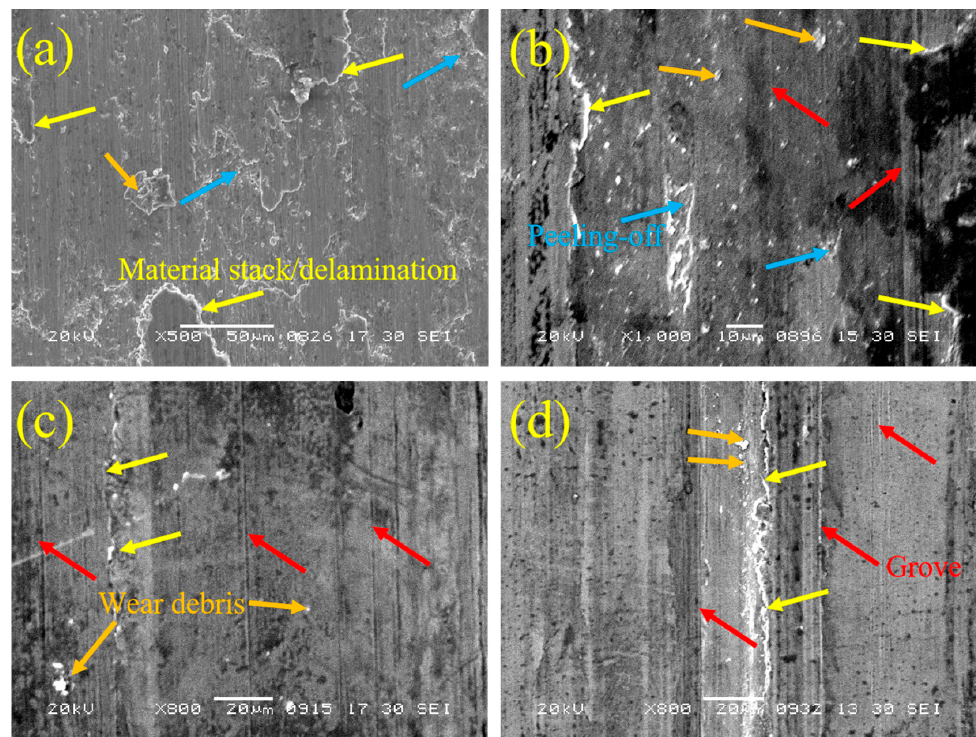
Figure 14. SEM images of worn surface morphology: ( a ) substrate; ( b ) sample LC1; ( c ) sample LC2; ( d ) sample LC3.